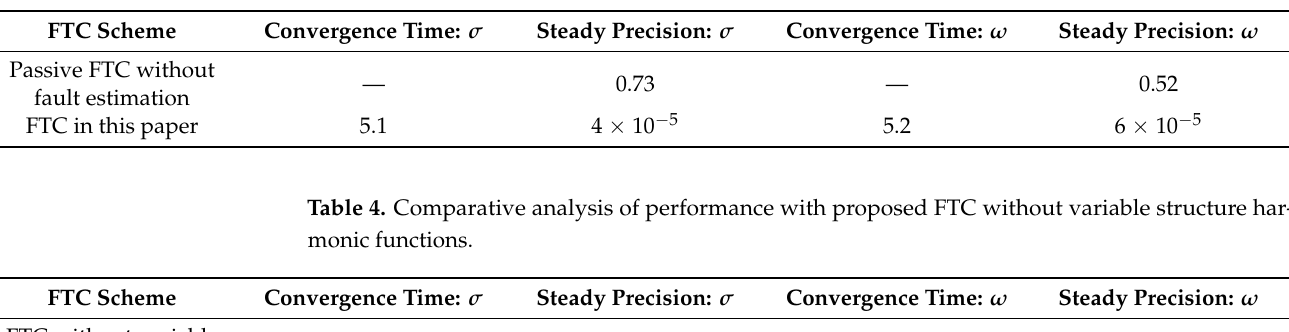
Table 4. Comparative analysis of performance with proposed FTC without variable structure har- monic functions.